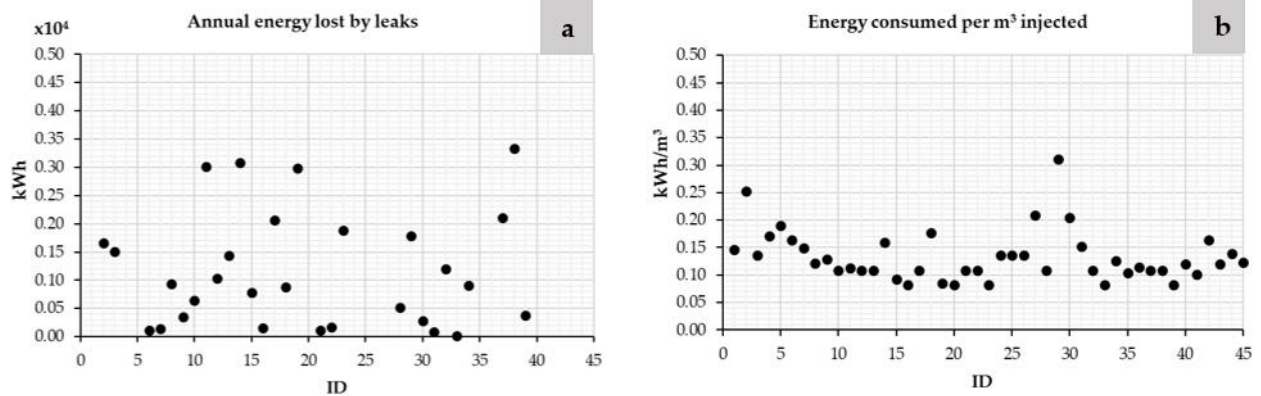
Figure 5. Annual energy lost by leaks ( a ) and energy consumed per m 3 injected ( b ).